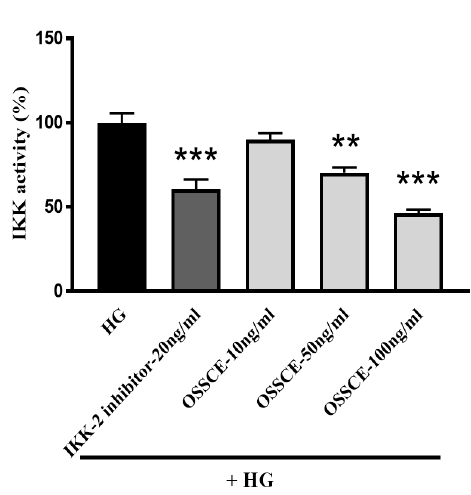
Figure 6. OSSCE inhibits the activation of NF- κ B in the retina of SDT rats and in HG-treated HRMECs and the activity of IKK-kinase. ( a ) The increased NF- κ B activity in the retina of SDT rats was decreased by OSSCE. The NF- κ B activity was measured by TUNEL staining. *** p < 0.001 vs. NOR; ### p < 0.001 vs. SDT (n = 3–5). ( b ) OSSCE and MCs suppressed NF-kB translocation into the nucleus in HG-treated HRMECs. *** p < 0.001 vs. Con; ### p < 0.001 vs. HG (n = 4). ( c ) The inhibitory effect of OSSCE on the